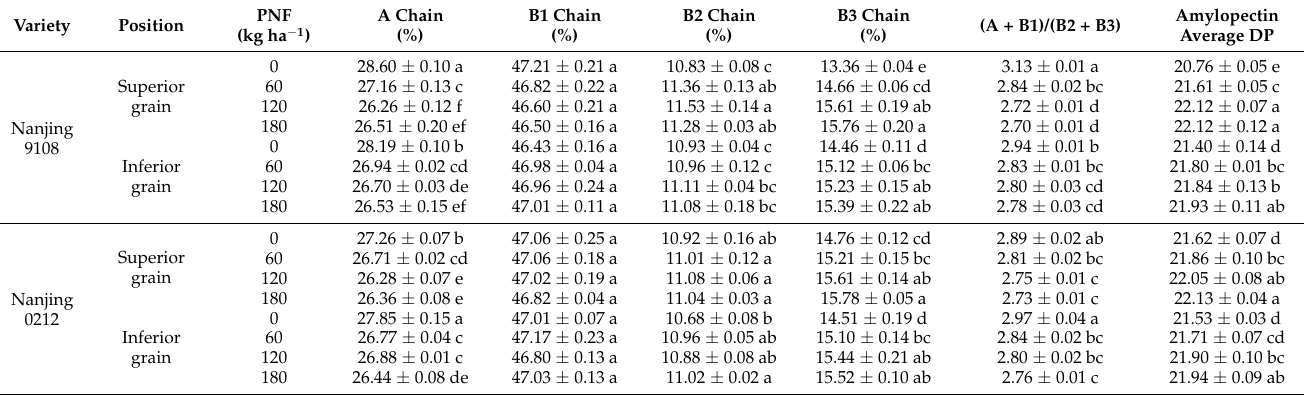
Table 4. Amylopectin chain length distributions of superior and inferior grains of japonica rice under different PNF